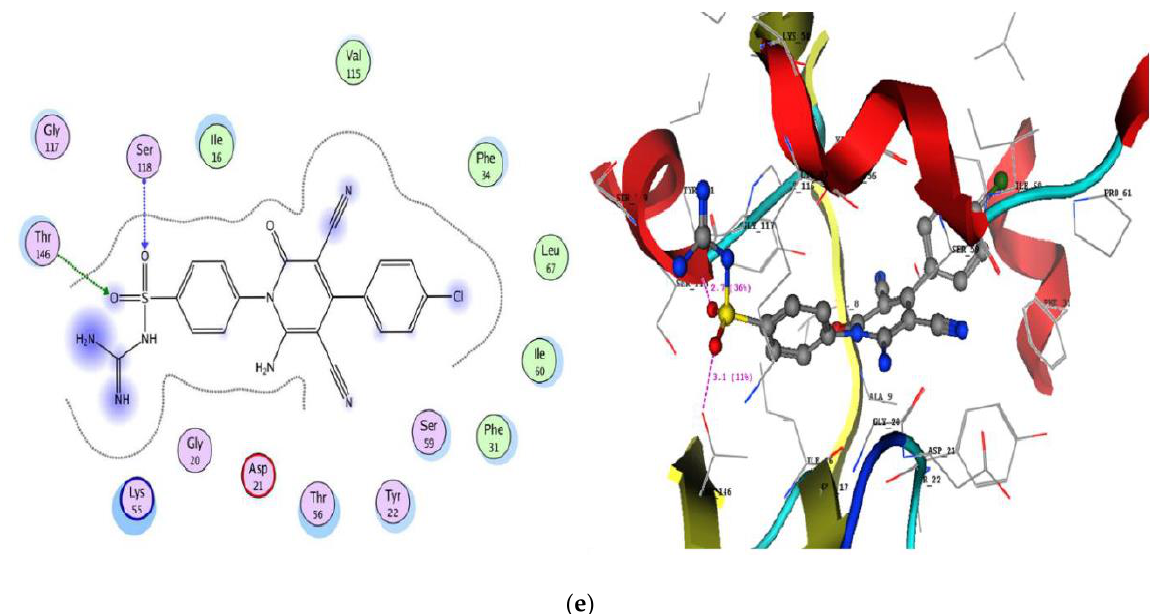
Figure 3. ( a ) 2D and 3D structure of compound 2d inside the active site DNA gyrase (2XCT). ( b ) 2D and 3D structure of compound 3a inside the active site DNA gyrase (2XCT). ( c ) 2D and 3D structure of compound 2a inside the active site DHFR (1DLS). ( d ) 2D and 3D structure of compound 2d inside the active site DHFR (1DLS). ( e ) 2D and 3D structure of compound 3a inside the active site DHFR (1DLS).